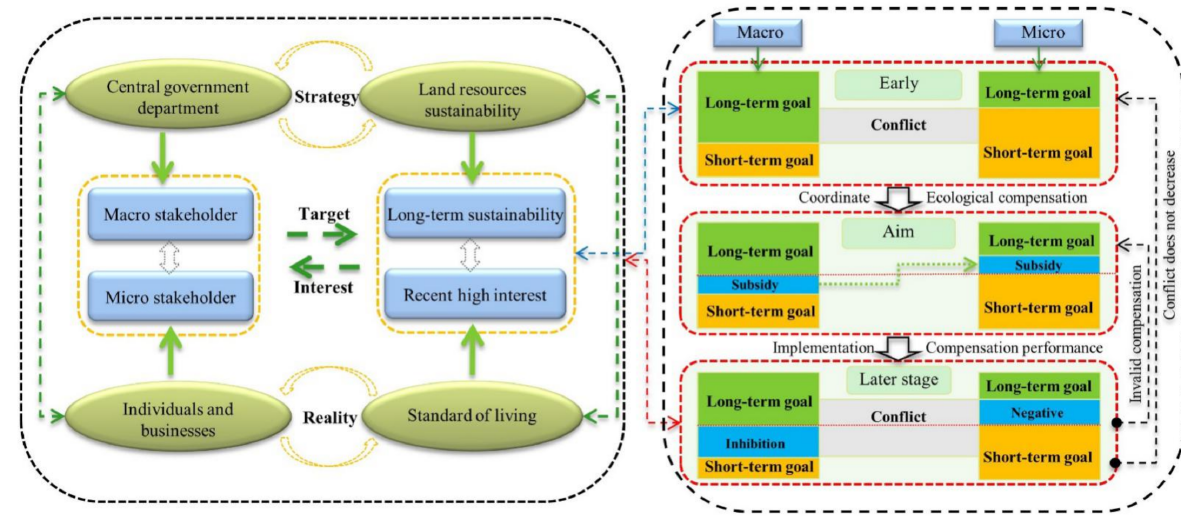
Figure 7. Dilemma of the policy conflict. There were contradictions between the macro-stakeholders and the micro- stakeholders. Ecological compensation failed to achieve a balance between long-term and short-term